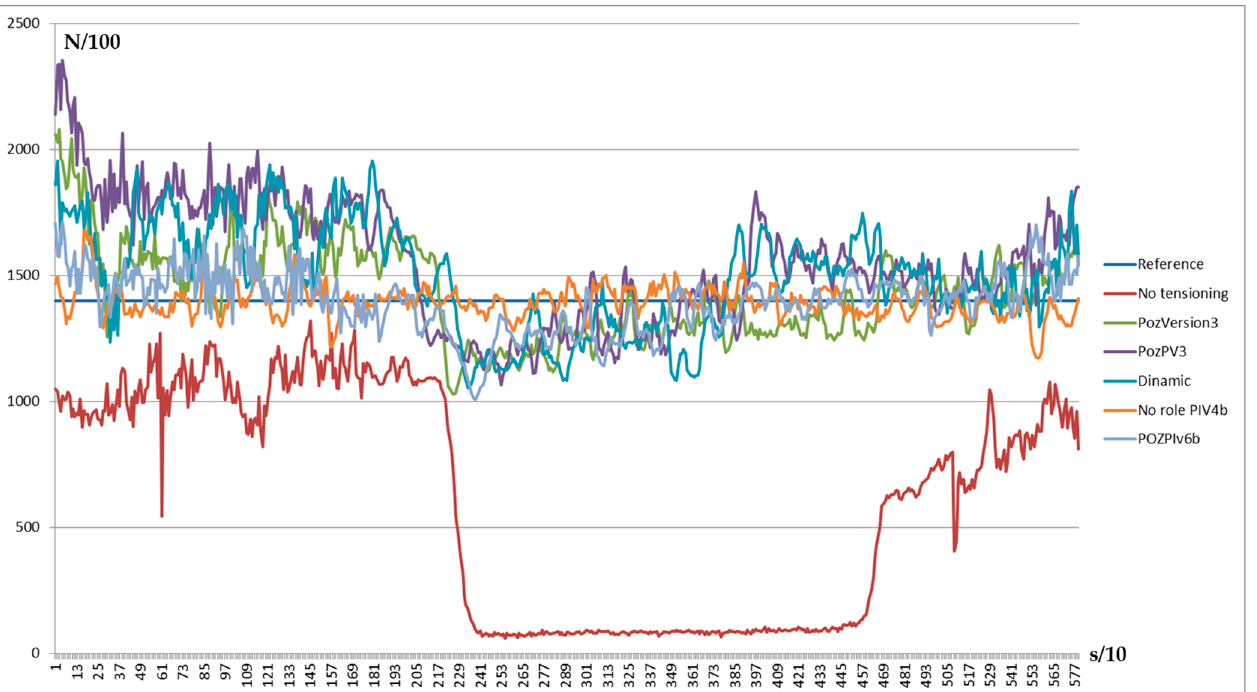
Figure 19. An increased amplifier and limited values control system.